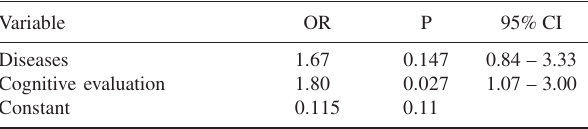
Table 5 - Functional loss – logistic regression Variable OR P 95% CI Diseases 1.670